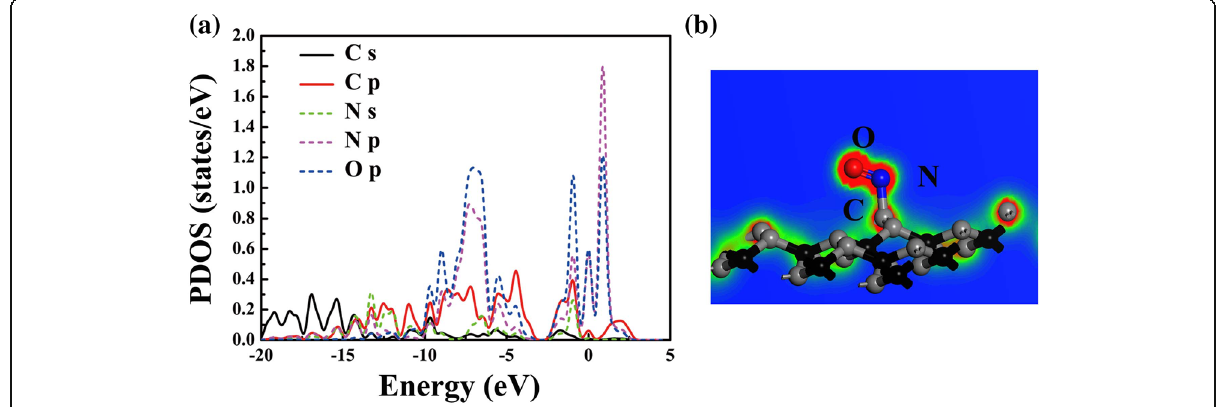
Fig. 5 The atom projected DOS ( a ) and electron localization function (ELF) of NO-PG ( b